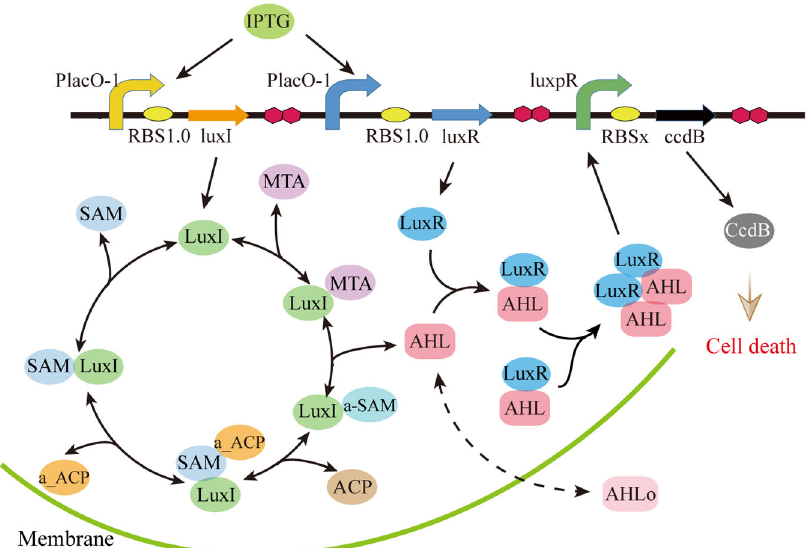
Fig. 1 Schematic representation of the synthetic quorum sensing signaling that controls bacterial population density. The subscript “ x ” in RBSx represents different RBSs, such as RBS 0.07 , RBS 0.3 , and RBS 1.0